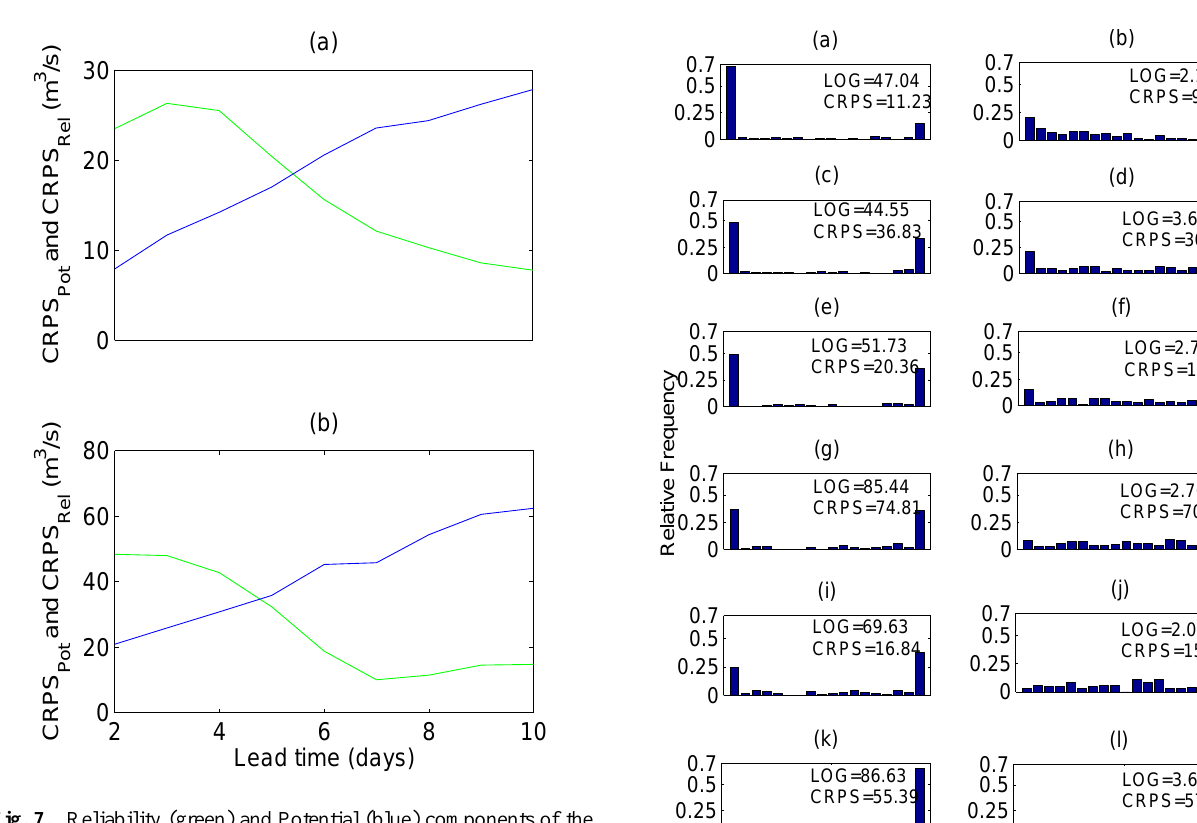
Fig. 7. Reliability (green) and Potential (blue) components of the mean CRPS before post-processing of the ensembles for (a) Paugan and (b) Baskatong. Table 2. Variance of the best member errors for Maniwaki sub- catchment, divided according to the percentiles of the distribution of observed streamflow, for calibration period (2 March 2002 to 15 July 2003).